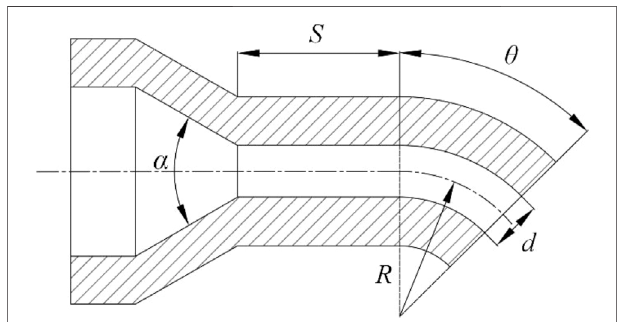
FIGURE 1 | Rotating spinning system.